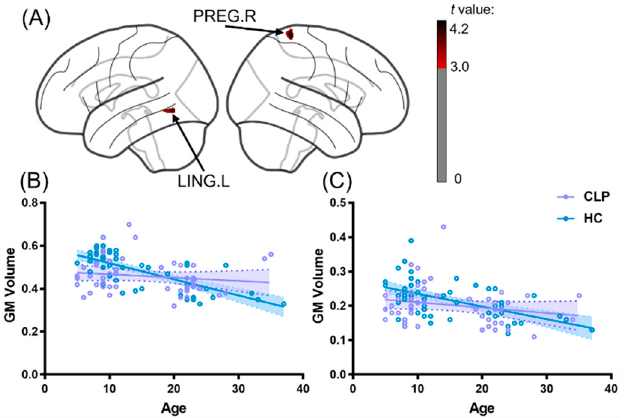
Figure 2. Speci fi c gray ma tt er (GM) regions showed signi fi cantly di ff erent correlations with age be- tween CLP and HC. ( A ) Anatomical locations of brain regions whose GM volume exhibited signi fi - cant interaction e ff ects between group and age, including the left lingual cortex (LING.L) and the right precentral cortex (PREG,R); ( B ) age slopes of regional GM volume in LING.L in CLP and HC; ( C ) age slopes of regional GM volume in PREG.R in CLP and HC. Gender and total intracranial volume (TIV) were regressed out as covariates, and signi fi cance is set at cluster-wise Gaussian the- ory fi eld (GRF)-corrected p < 0.05. Table 2. Group di ff erences in gray ma tt er (GM) intensity based on volume-based morphometry analyses.